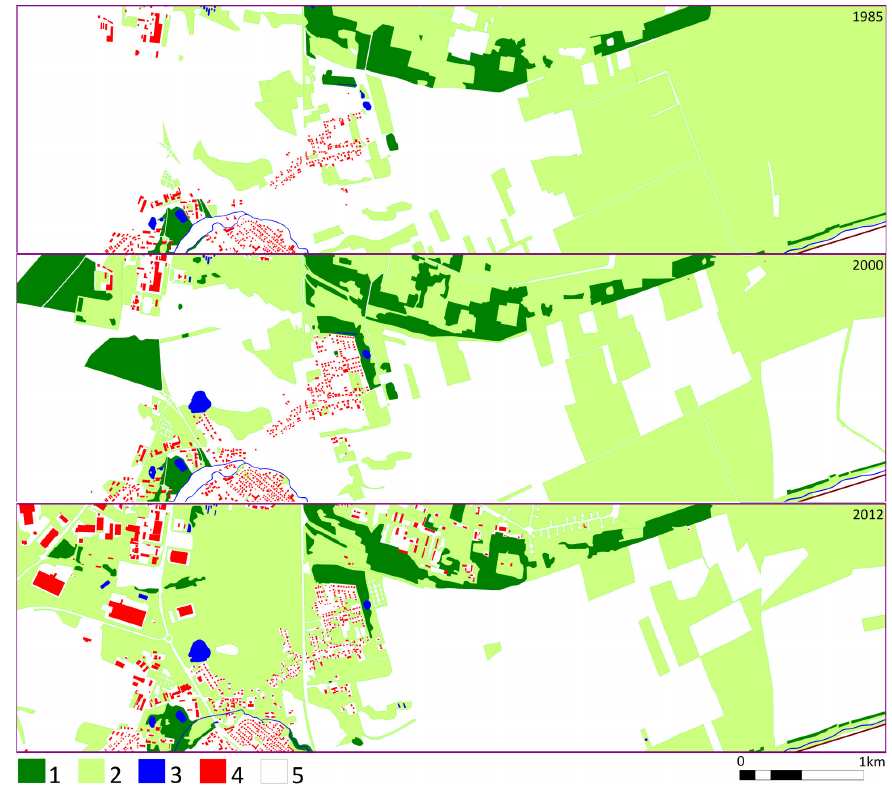
Fig. 4. State of the coverage of testing ground D in 1985, 2000 and 2012. Source: own